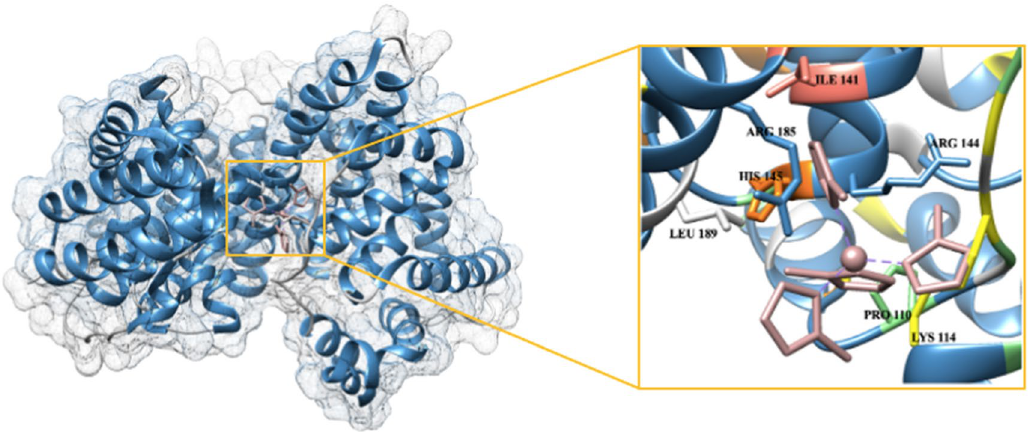
Figure 9. Surface view showing interaction between protein (blue) and ZIF-8 SBU (pink) with an enlarged image of the binding groove showing amino acid residues involved in molecular